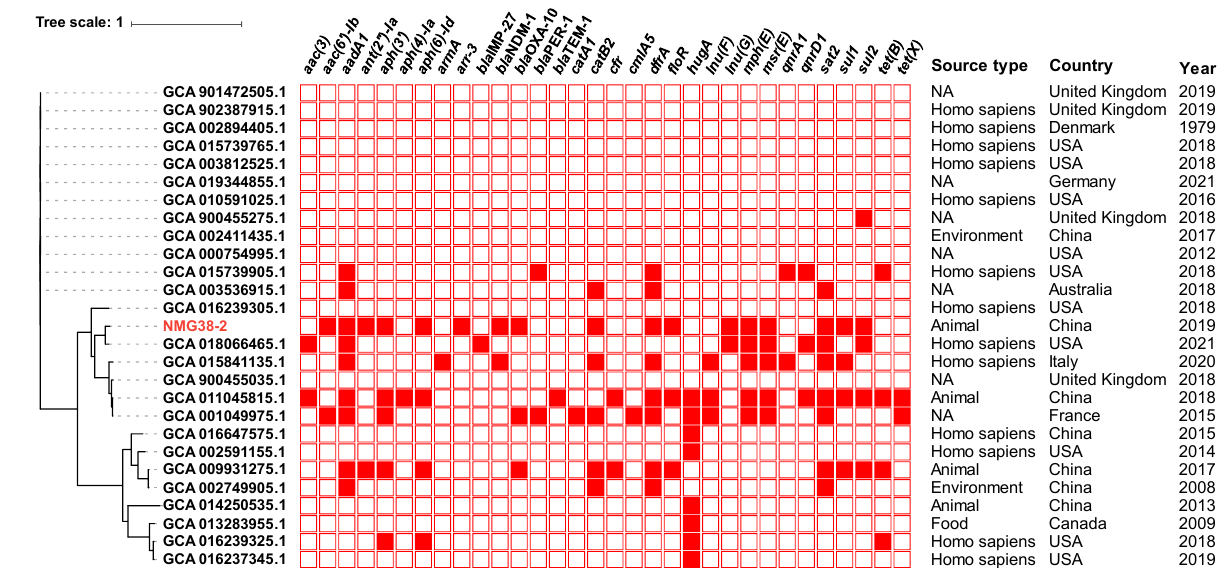
Figure 1. Phylogenetic tree of the Proteus sp. NMG38-2 with 26 P. vulgaris genomes available from GenBank. The tree is based on 1323 core genes with 232,421 SNPs and the tree scale indicates substitutions per site. NMG38-2 is indicated in red. Resistance gene profiles are visualized in compliance to the tree. The annotation denotes (from left to right) isolation sources, locations and years of strains. NA, not available.